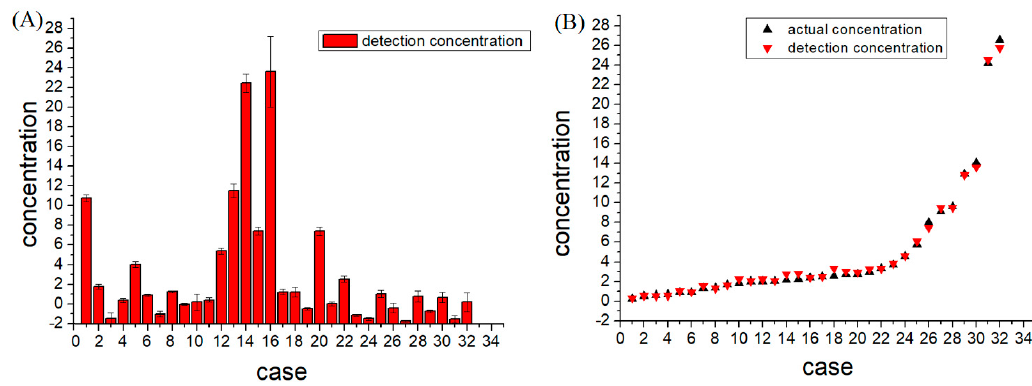
Figure 5. CEA detection in clinical human serum samples. ( A ) the repeatability of actual samples; ( B )